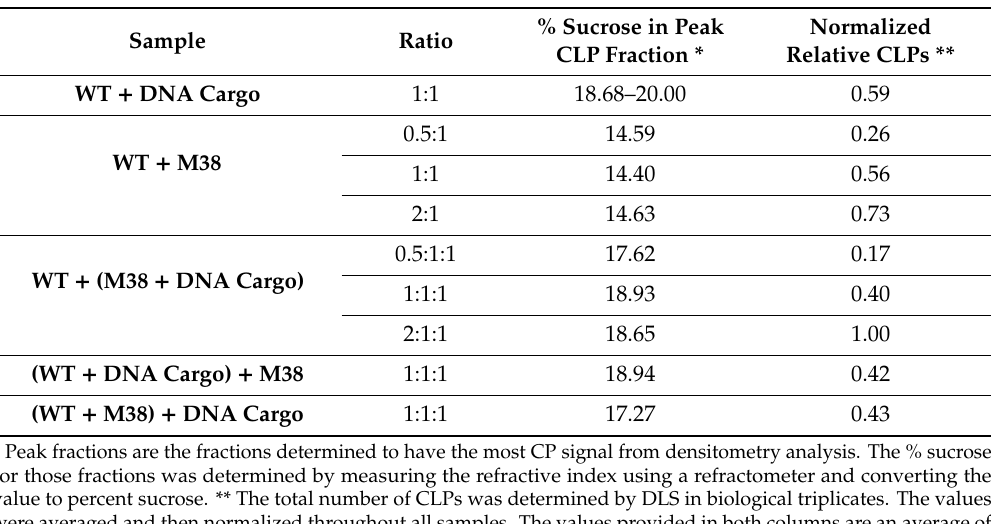
Table 1. Reaction conditions a ff ect the number and density of CLPs.